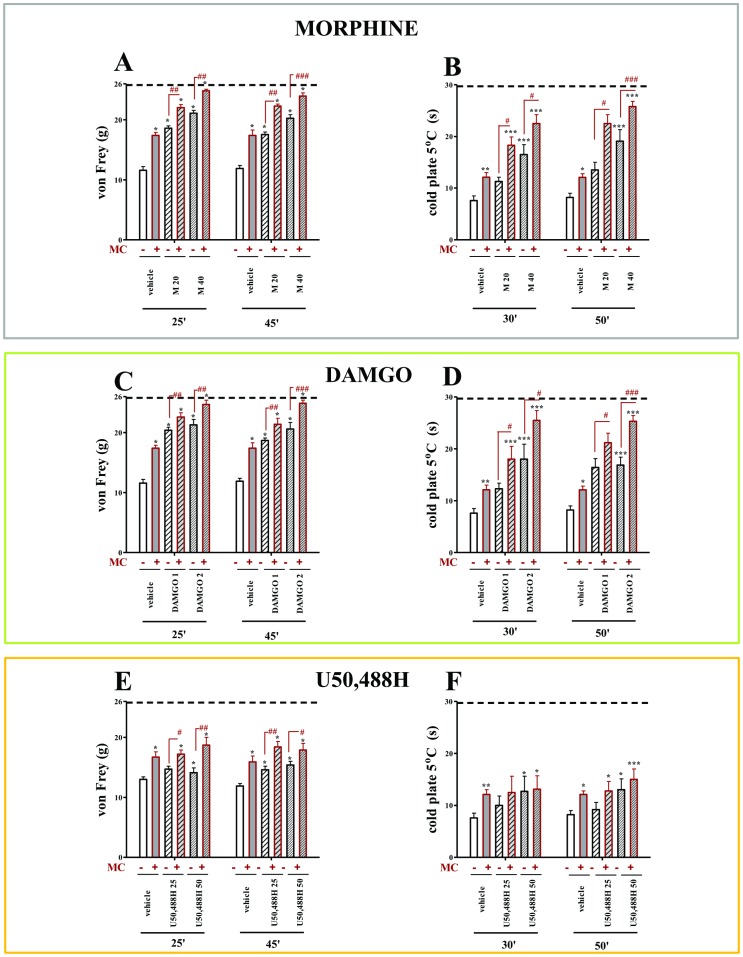
The effects of morphine, DAMGO and U50,488H on vehicle- and minocycline-treated CCI-exposed rats.The response to morphine, DAMGO and U50,488H was measured 25 and 45(A, C, E) and 30 and 50 minutes after administration by the cold plate test (B, D, F). Minocycline (MC; 30 mg/kg; i.p.) was administered intraperitoneally pre-emptively 16 h and 1 h before CCI, and then repeatedly twice daily for 7 days. Vehicle-treated and minocycline-treated rats received intrathecal morphine (M; 20; 40 µg/5 µl), DAMGO (1; 2 µg/5 µl) or U50,488H (25; 50 µg/5 µl) one hour after the last morning administration on day 7 after CCI. The data are presented as the mean response ± S.E.M. (8–16 rats per group). The results of the experiments were statistically evaluated using One-way Analyses of Variance (ANOVA). The differences between the treatment groups throughout the study were further analysed with Bonferroni's post-hoc tests. *P<0.05, **P<0.01 and ***P<0.001 indicate significant differences compared with vehicle-treated CCI-exposed rats; #P<0.05, ##P<0.01 and ###P<0.001 indicate significant differences between vehicle-treated CCI-exposed rats that received a single dose of morphine and minocycline-treated CCI-exposed rats that received a single dose of morphine, DAMGO or U50,488H. Dotted line is a value for naïve animals (for von Frey test 25.8 g; for cold plate test 29.7 s).